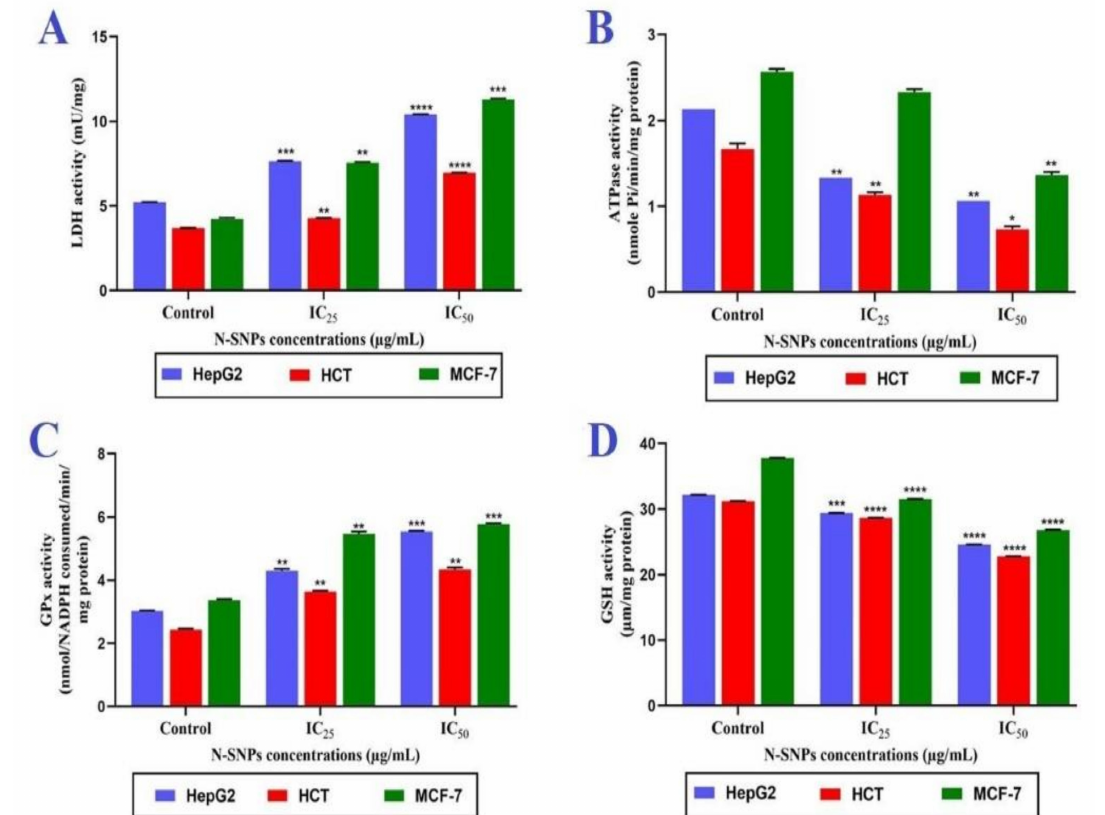
Figure 3. Influence of N-SNPs at IC25 and IC50 on enzymes and antioxidants in MCF-7, HCT-116, and HepG2 cells. ( A ) Lactate dehydrogenase (LDH) enzyme, ( B ) adenosine triphosphatase (ATPase), ( C ) glutathione peroxidase (GPx), and ( D ) glutathione (GSH). All of the data were collected from independent experiments performed in triplicate and are presented as mean ± SEM. p -values were calculated versus untreated cells: **** p < 0.0001, *** p < 0.0003, ** p < 0.001, *p <